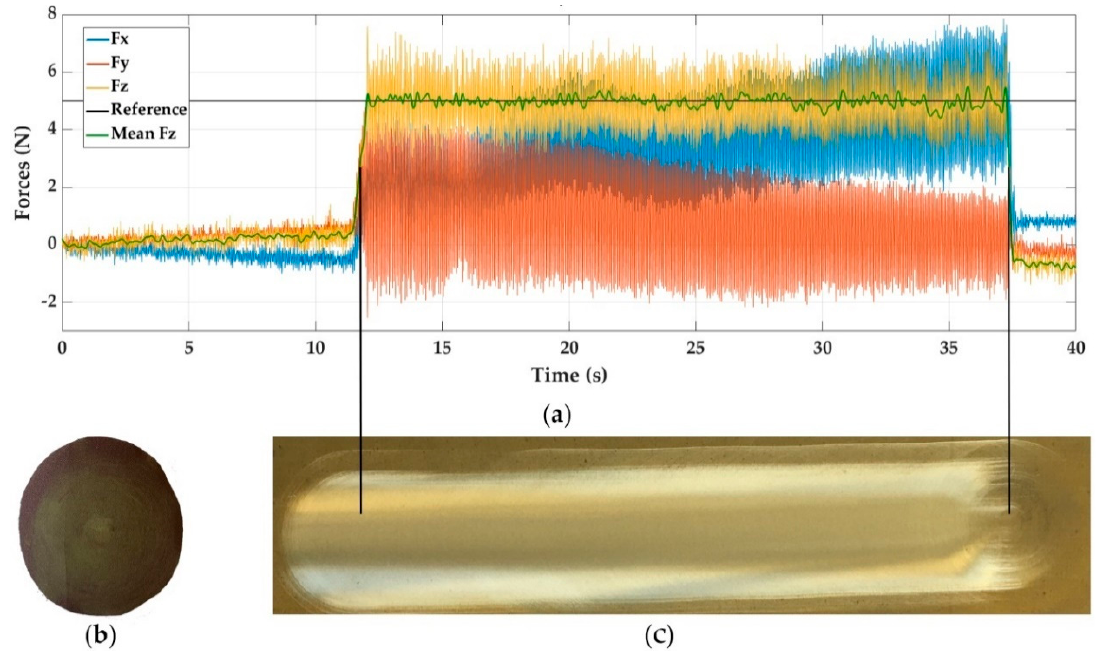
Figure 6. Experiment E12, sanding brass with PIV control and reference force of 5 N. ( a ) Force response, ( b ) sandpaper aspect, and ( c ) visual surface finish.